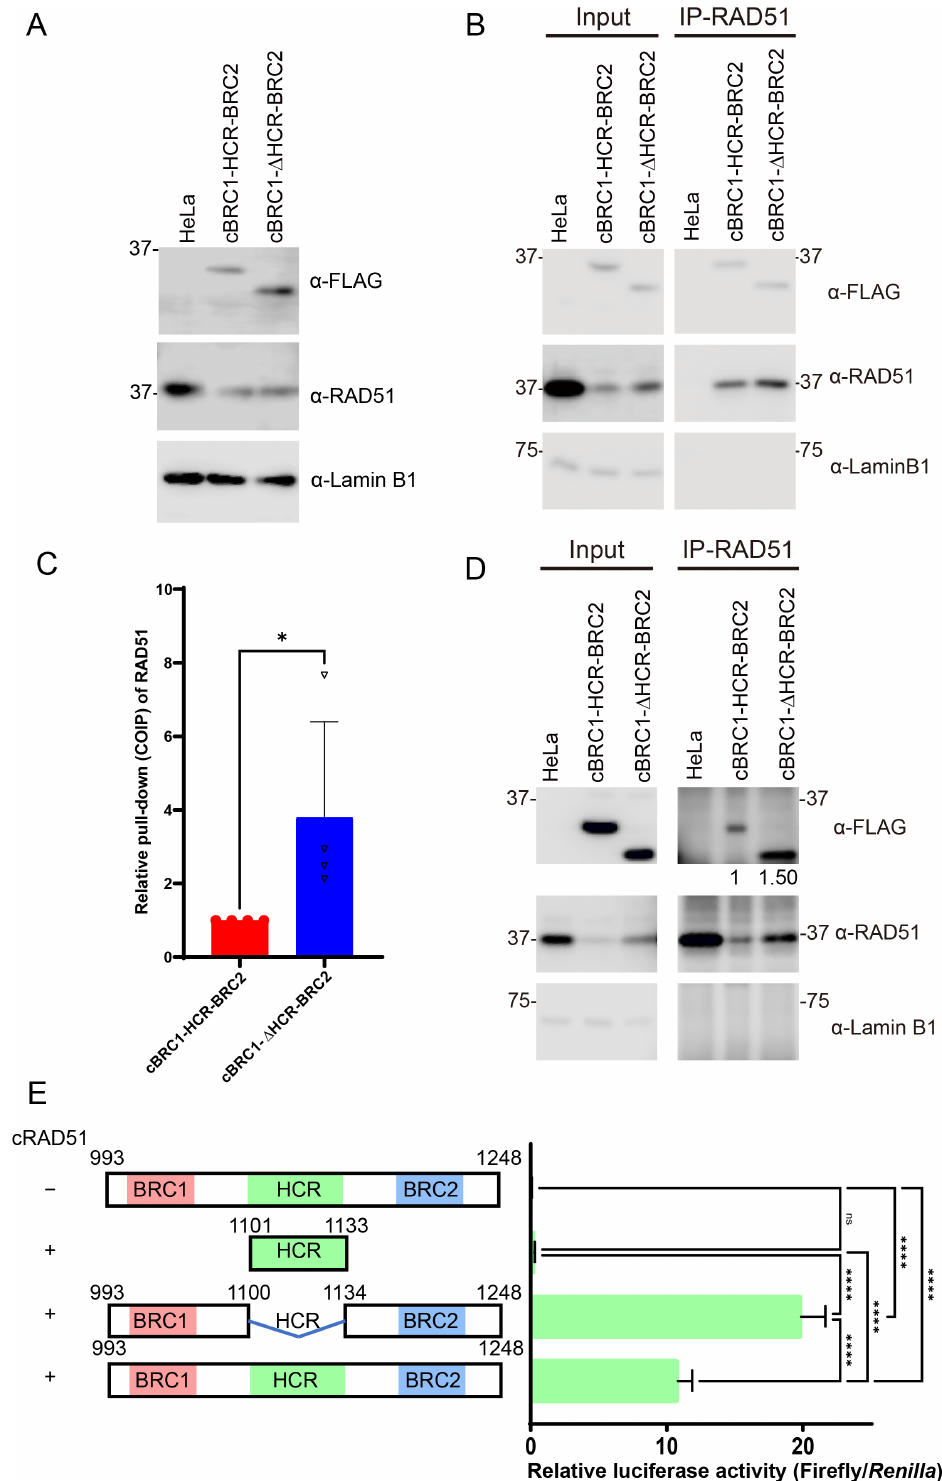
Figure 3. The highly conserved region (HCR) does not interact with RAD51 but reduces the interaction of BRC repeat 1 (BRC1) and 2 (BRC2) with RAD51. ( A ) Expression of exogenous BRCA2 peptides and endogenous RAD51. HeLa cells stably expressing FLAG-HA-tag and nuclear localization signal (NLS)-fused cBRC1-HCR-BRC2 and cBRC1- Δ HCR-BRC2 were determined via Western blotting using anti-FLAG and anti-RAD51 antibody, and anti-Lamin B1 antibodies (as loading control) ( B ) The RAD51 interactions of the cBRC1-HCR-BRC2 (993–1248 aa) and cBRC1- Δ HCR-BRC2 (993–1248 aa deleted with 1101–1133 aa) were compared using co-immunoprecipitation. The